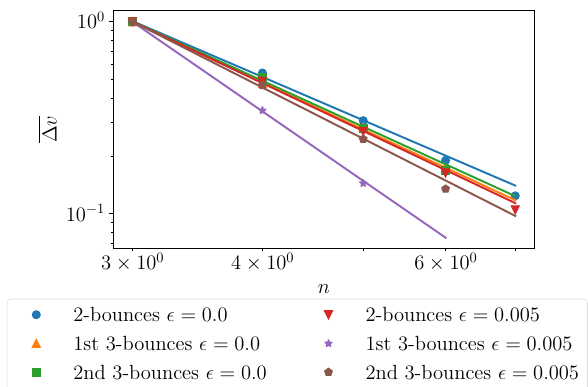
Fig. 11 Normalized width of the resonance windows versus window numberinlogscaleforthetwo-bouncewindowsandsomethree-bounce windows. The figure shows approximately the same slope for (cid:9) = 0 . 0, in contrast with (cid:9) = 0 . 005 case. Parameters are γ = 2 . 667, (cid:8)γ = 2 . 0 and (cid:9) = 0 . 0 , 0 .